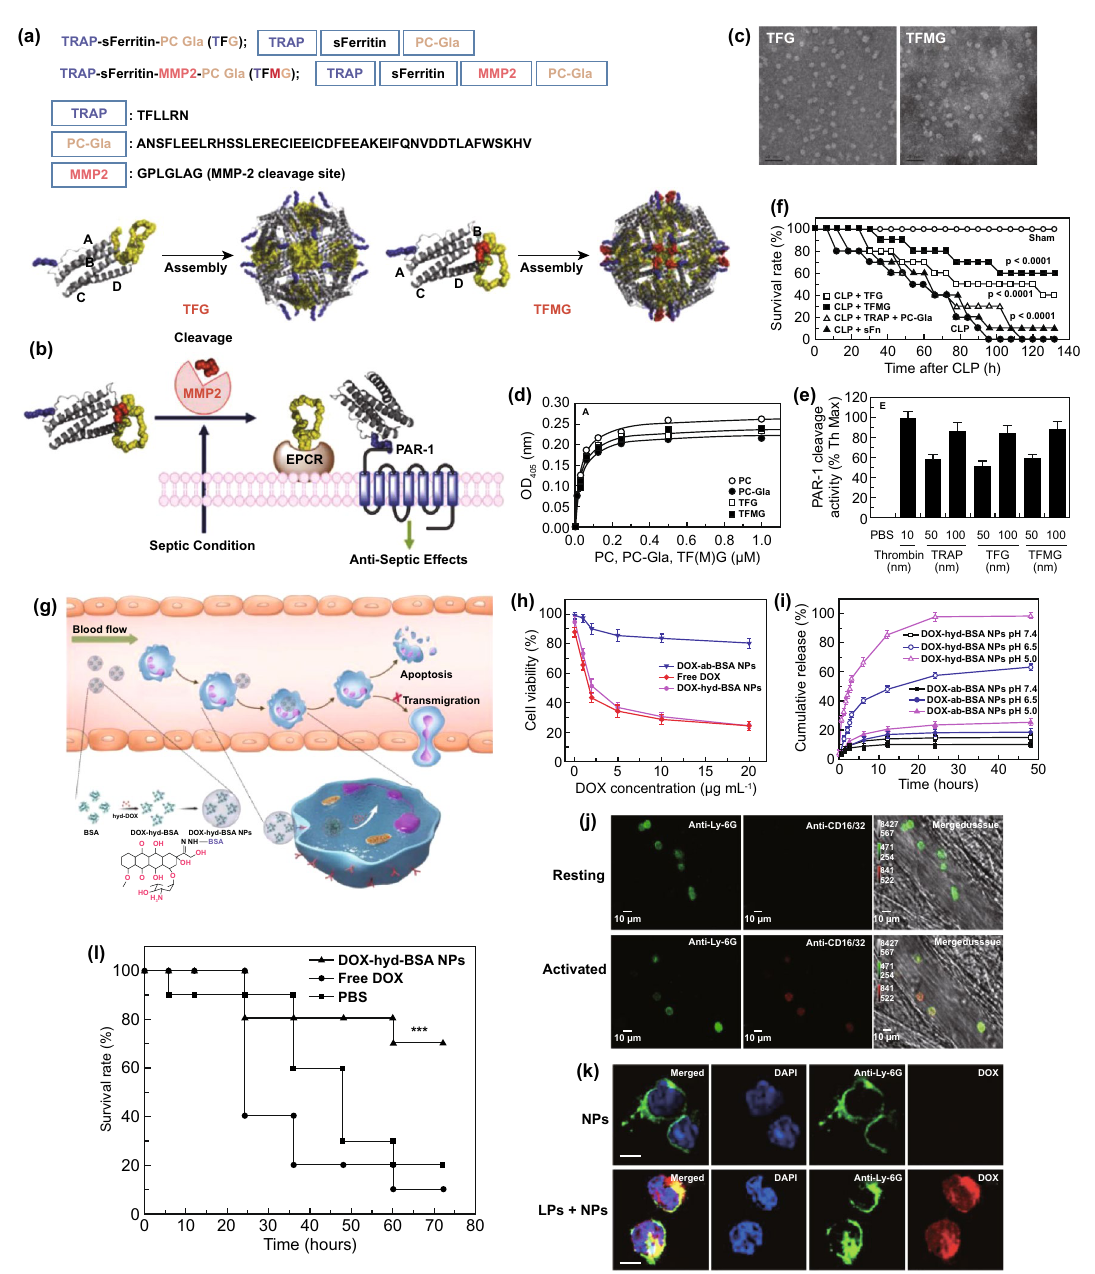
Fig. 18 Double-chambered protein nanocage loaded with TRAP and PC-Gla for sepsis management. a Structure and sequence of TFG and TFMG and their self-assembly behaviors. b Schematic illustration of the septic microenvironment responsive property of TFMG. c TEM images of TFG and TFMG. d Affinity of PC, PC-Gla, TFG, and TFMG to sEPCR were determined by ELISA. e PAR-1 cleavage activity of thrombin, TRAP, TFG, and TFMG. f Survival rates of CLP models with various treatments. Reproduced with permission from Ref. [243]. Copyright 2015 John Wiley and Sons, Inc. DOX-conjugated protein prodrug nanoparticles increase survival in sepsis by inducing neutrophil apoptosis. g Schematic illustration of DOX-hyd-BSA NPs inducing apoptosis of proinflammatory neutrophils for the treatment of inflammatory diseases. h Cell death of neutrophil-like HL-60 cells induced by free DOX, DOX-ab-BSA NPs, or DOX-hyd-BSA NPs. i Cumulative release of DOX from DOX-hyd-BSA NPs or DOX-hyd-BSA NPs in PBS at pH 7.4, 6.5, or 5.0. j Intravital microscopy of mouse cremaster muscle venules shows that neutrophil (anti-Ly-6G, green fluorescence) activation was associated with upregulation of Fcγ receptors (anti-CD16/32, red fluorescence). k Confocal laser scanning microscopy (CLSM) images of blood neutrophils from normal mice or LPS-challenged mice. Both mice underwent treatment with DOX-hyd-BSA NPs at 4 h post-LPS injection. l Survival rates of LPS-induced septic mice after treatment with PBS, free DOX, DOX-hyd BSA